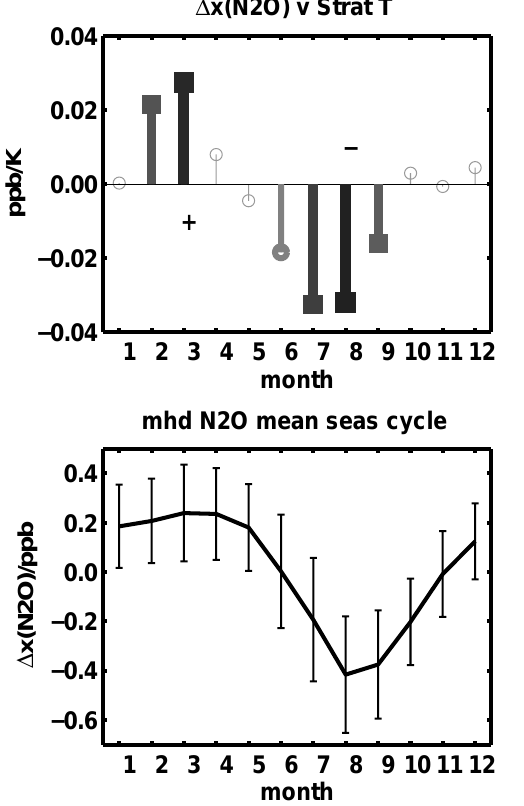
Fig. 6. (a) Stem plot summarizing the correlation slopes be- tween AGAGE detrended N 2 O monthly means at Mace Head and northern polar winter lower stratospheric temperature from Fig. 5. Heavy lines indicate statistically significant correlations. The darker the line, the higher the R value. Negative slopes in July– September indicate deeper minima at warmer stratospheric temper- ature, (b) “mean” seasonal cycle at Mace Head for AGAGE N 2 O, with error bars showing the standard deviation for each month.